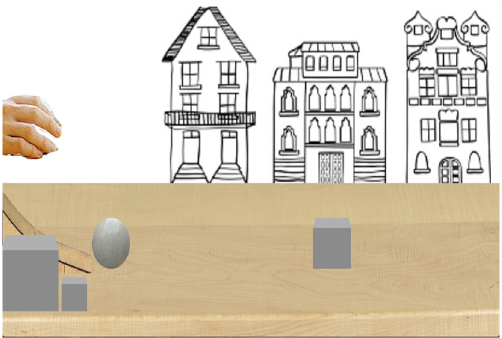
Figure 4. The habituation event infants watched before test events.